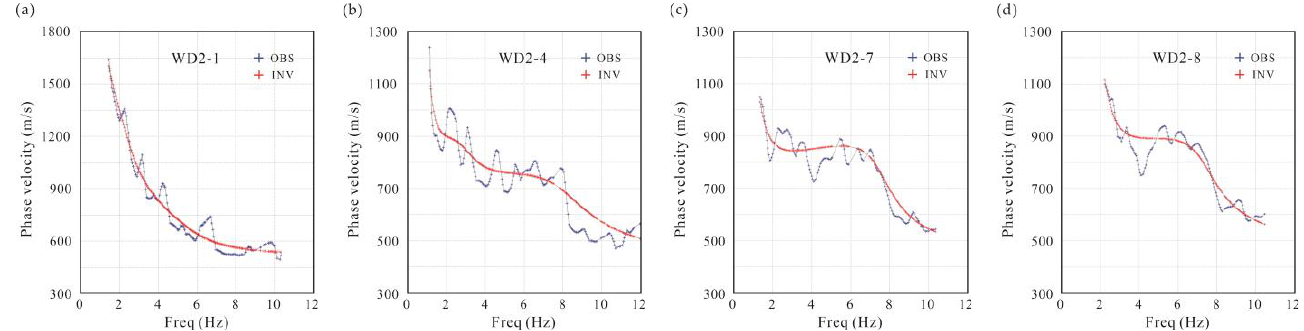
Figure 9. Dispersion curve of some measuring points of WD2 line. ( a ) the dispersion curve of WD2-1; ( b ) the dispersion curve of WD2-4; ( c ) the dispersion curve of WD2-7; and ( d ) the dispersion curve of WD2-8.